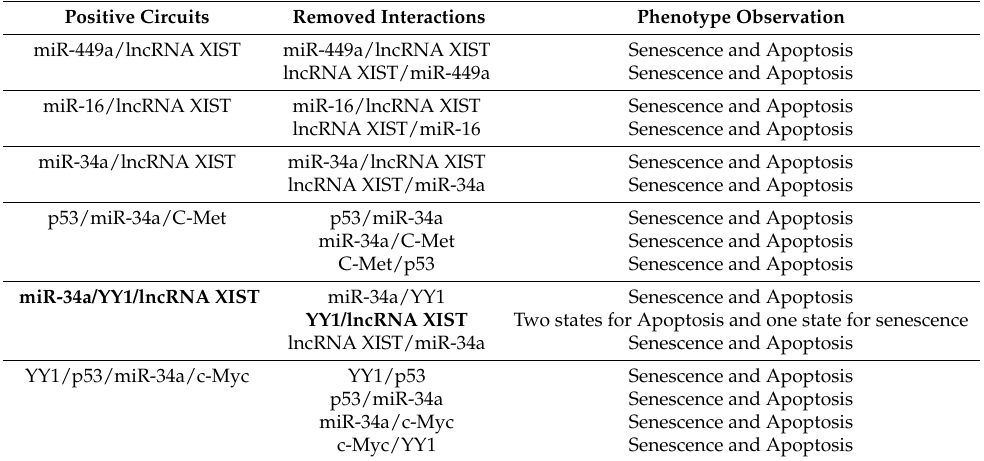
Table 4. Circuits and their corresponding perturbations that were found to responsible for three states or more are highlighted in bold fonts. Point to be noted here other 1 state means undefined state (for more detail see the